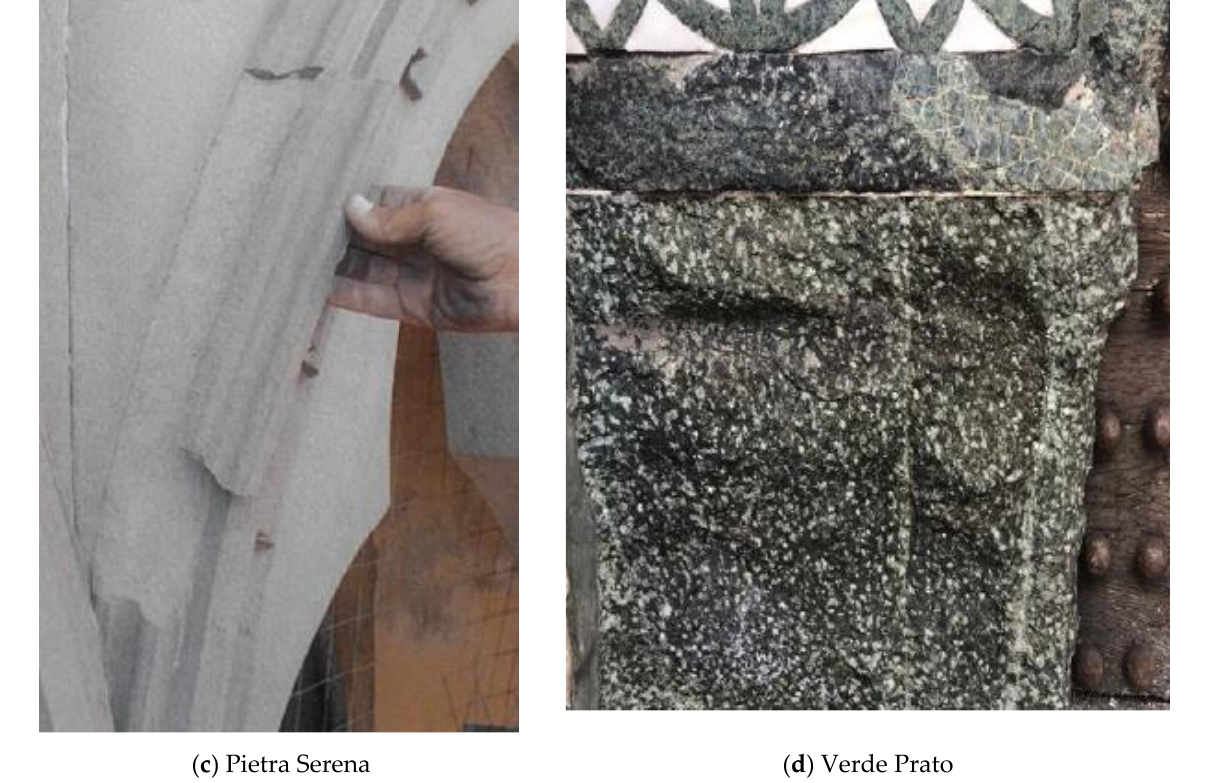
Figure 7. Examples of the decay processes typical of the building stones in place in the Prato Cathedral and Bell Tower.